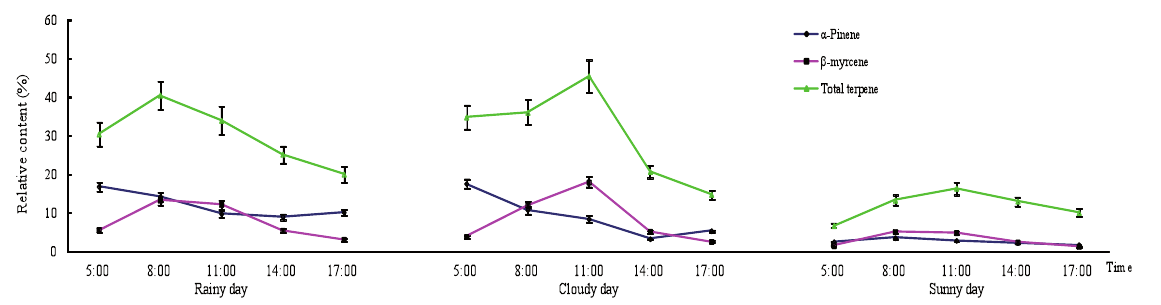
Fig. 5: Diurnal dynamics of terpenes in volatile emissions from flowers of four seasons rose